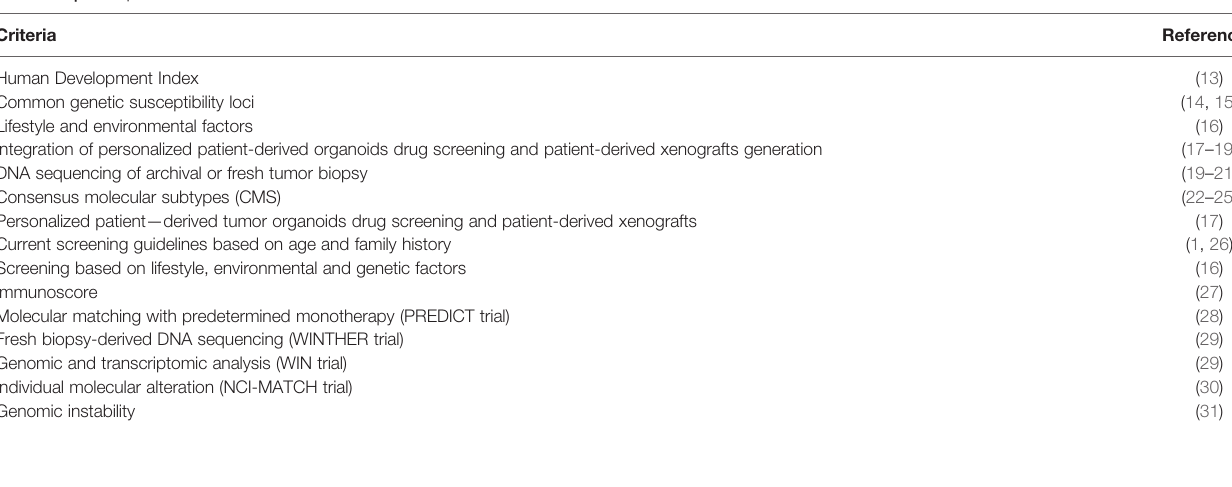
TABLE 1 | CRC patients ’ strati fi cation